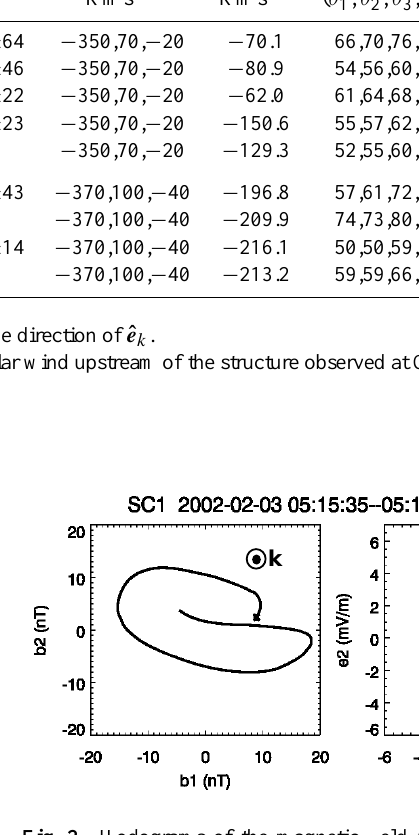
Fig. 2. Hodograms of the magnetic field (left) and electric field (right) for interval A3, which show right hand polarization with re- spect to the k vector (pointing out of the paper) in the spacecraft frame. The star signs are the starting points of the